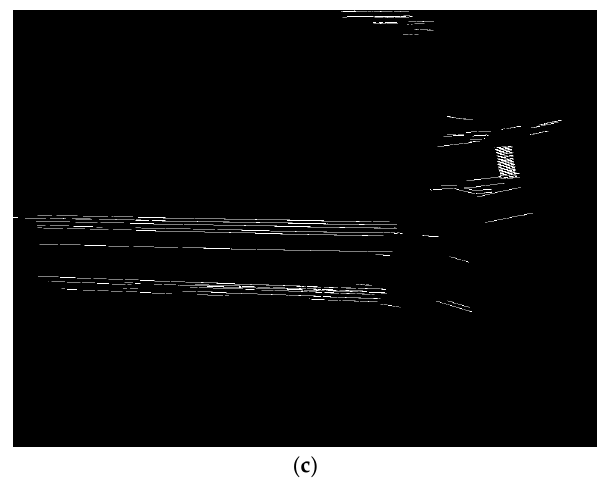
Figure 9. Example of horizontal line extraction.